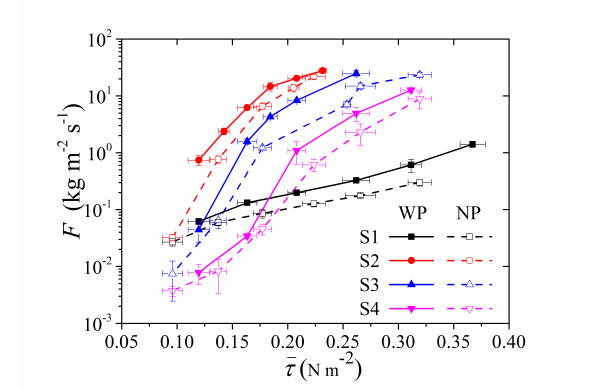
Figure 4. Entrainment rate of four different soils observed in the NP and WP runs. Open symbols represent the NP runs and solid symbols the WP